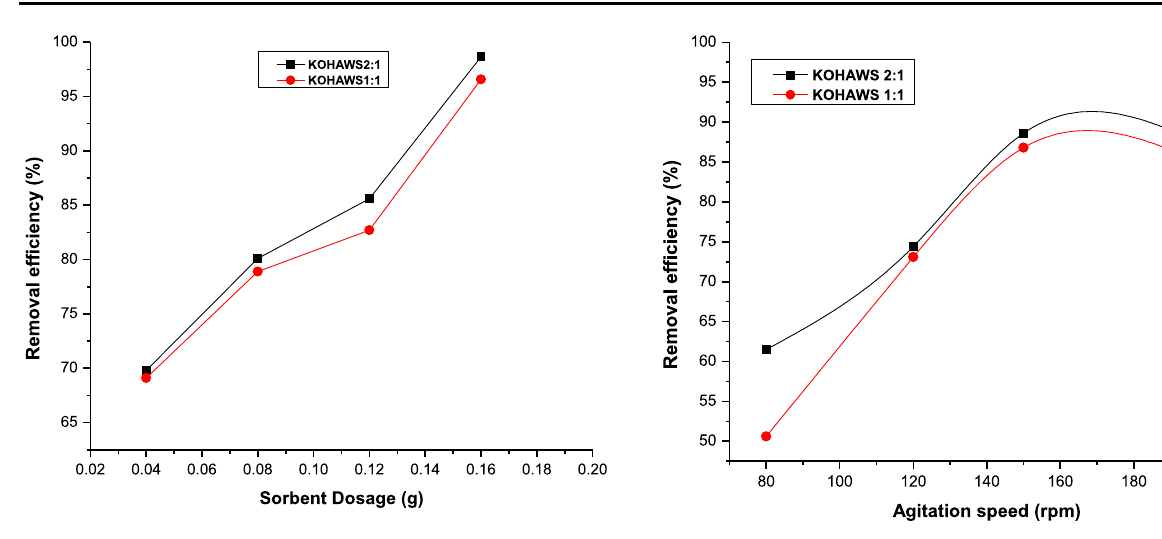
Fig. 9 Effect of agitation speed on deltamethrin